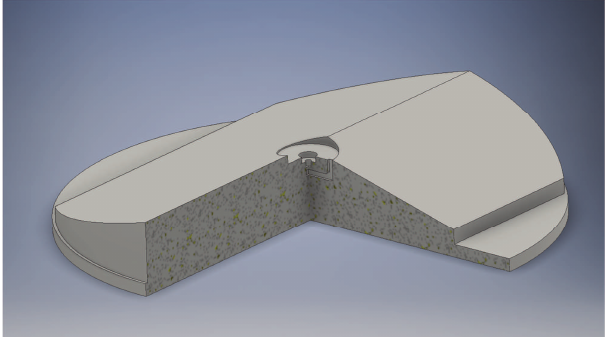
Fig. 5. The part-section view of the combustion chamber with outlined spark plug in the centre of the chamber